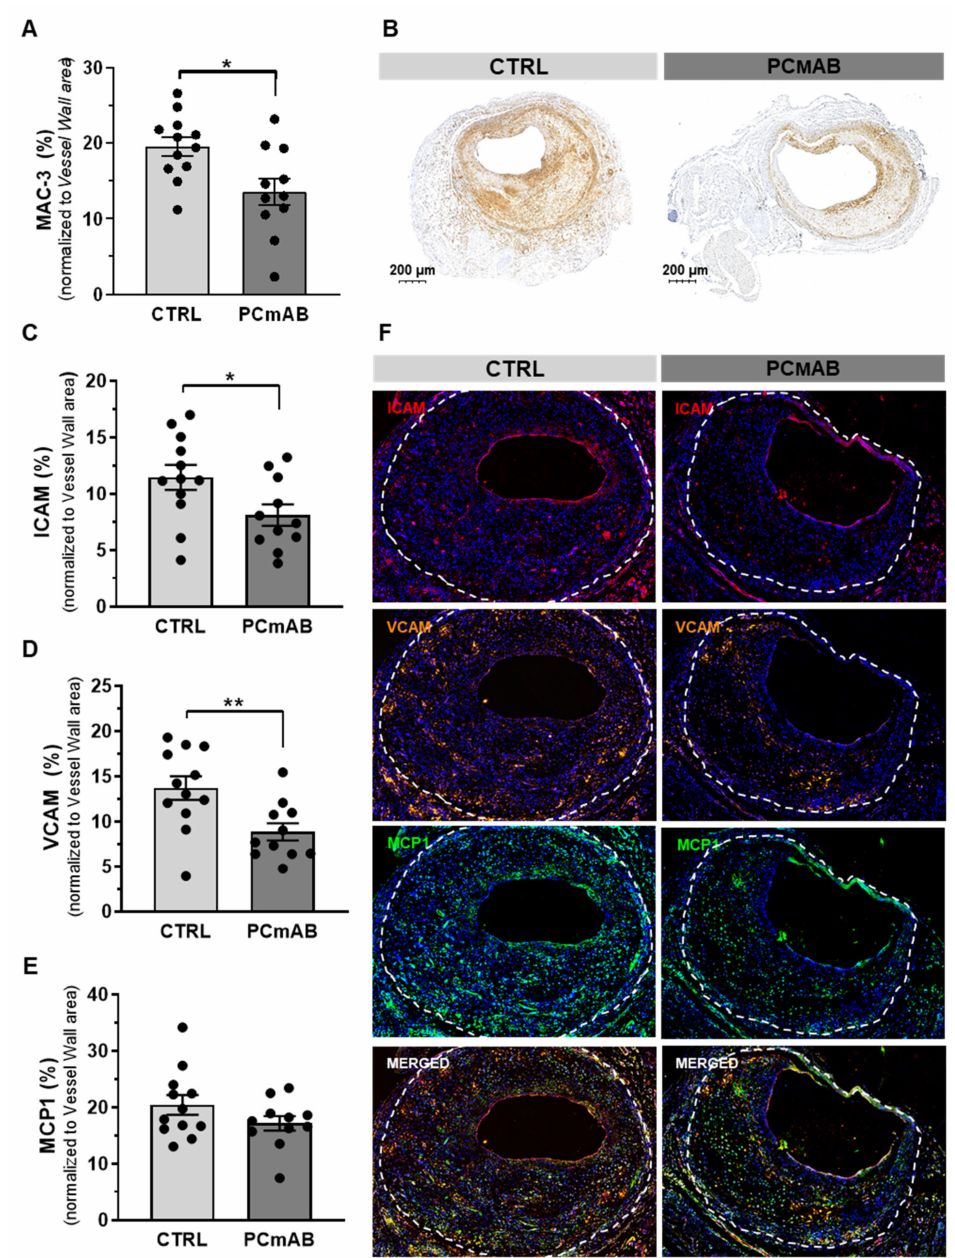
Figure 3. PC-mAb improves plaque inflammation by decreasing macrophage content and VCAM and ICAM expression. Quantification of % MAC-3 ( A ), Representative VG sections ( B ) and adhesion and inflammation associated factors ICAM-1 ( C ), VCAM-1 ( D ) and MCP-1 ( E ) expression in the CTRL (n = 12) and PC-mAb group (n = 11). Representative VG sections ( F ) Data presented as mean ± SEM. * p ≤ 0.05, ** p ≤ 0.01 by t